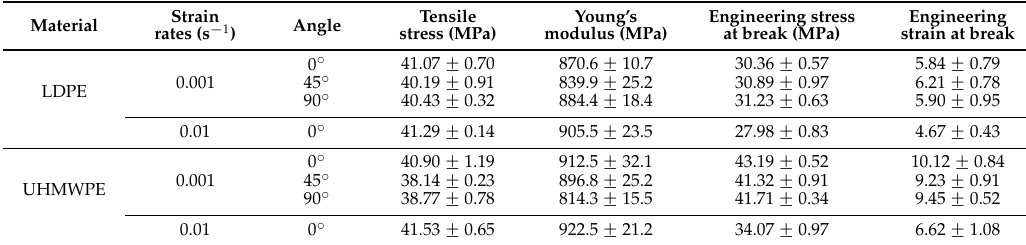
Table 3. Summary of quasi-static tensile test results for LDPE and UHMWPE. Averages of duplicate tests are shown